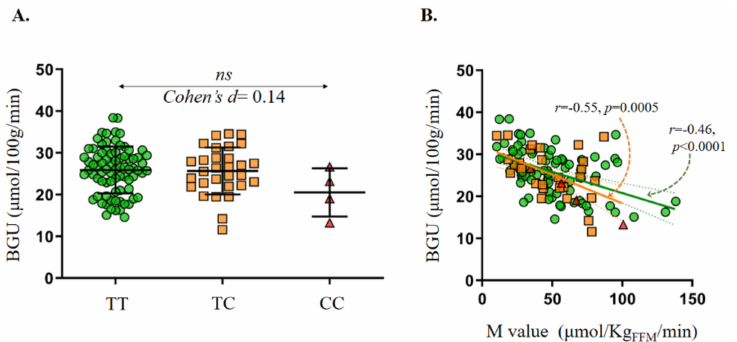
Figure 1. No difference in BGU during insulin stimulation was found between the subjects homozy- gous or heterozygous for rs17782313-C allele as compared to the carriers of the TT genotype ( A ). Clamp BGU correlated negatively to the M value in both the subjects carrying the rs17782313-C allele and the carriers of the TT genotype ( B ). In 1A mean ± SD is given. In 1B the orange line represents the slope and 95% Confidence interval for the grouped TC/CC